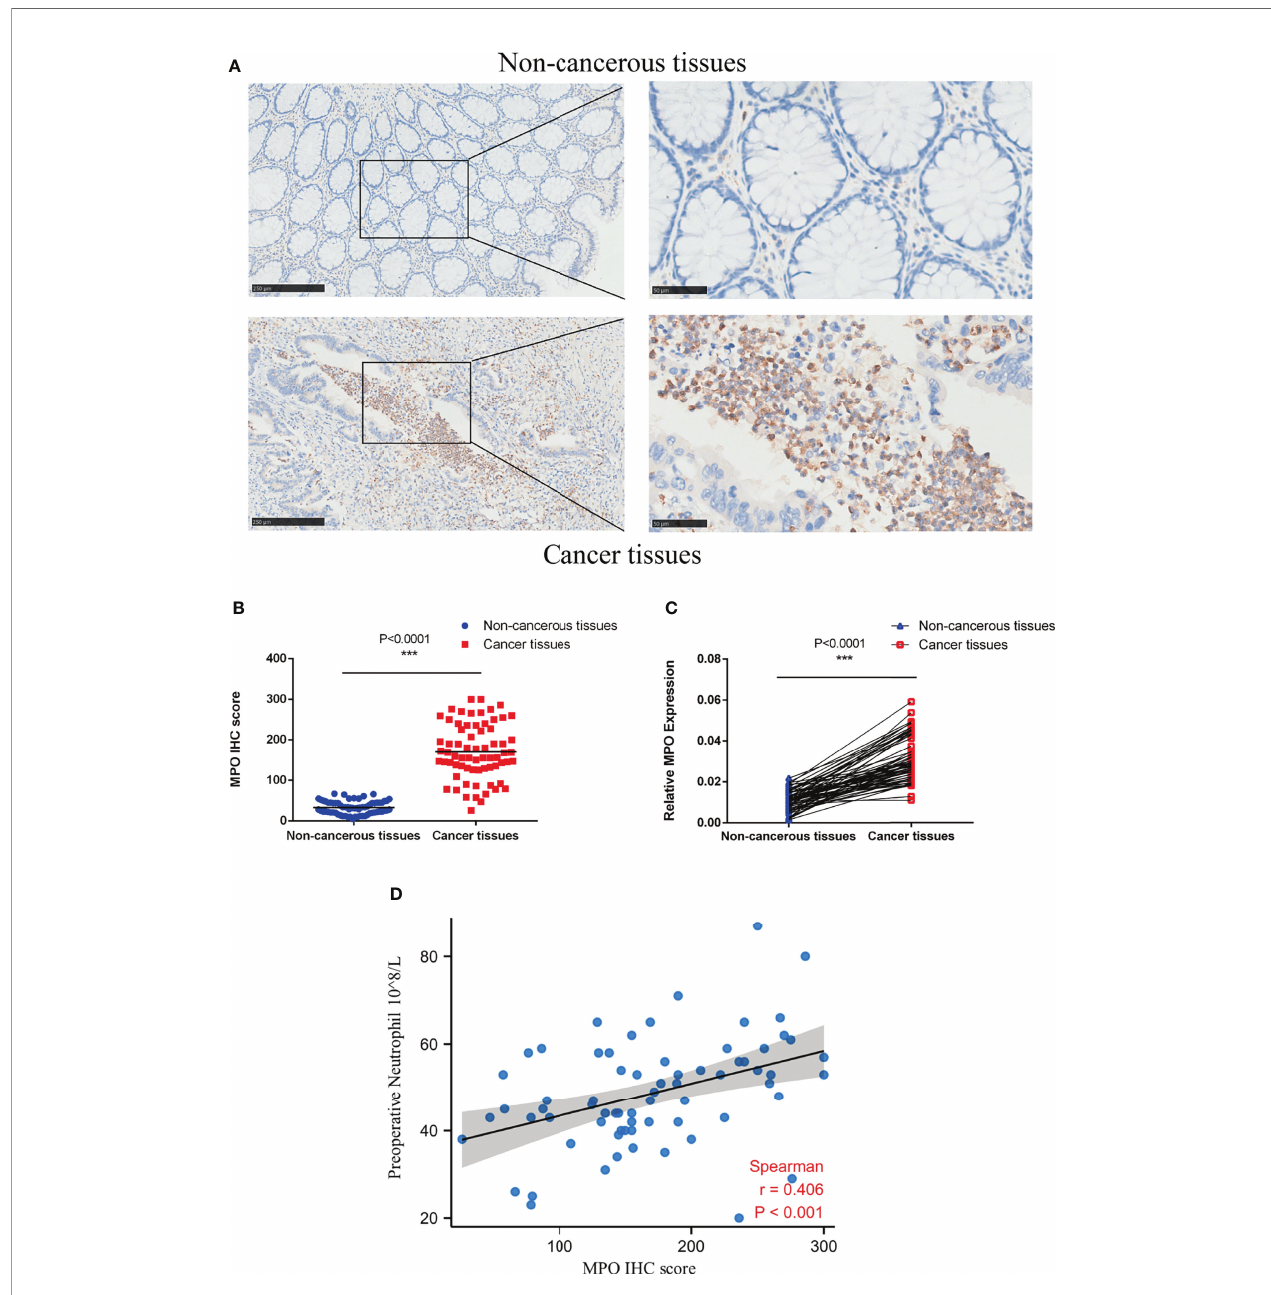
FIGURE 5 | MPO was upregulated in CRC and positively correlated with peripheral neutrophil counts. (A) IHC was used to detect MPO protein expression in CRC and non-cancerous tissues (69 pairs); left, scale bar = 250 µm; right, scale bar = 50 µm. (B) Quantitative analysis of MPO IHC scores in CRC and non-cancerous tissues (69 pairs). (C) qPCR was used to evaluate the relative expression of MPO mRNA in CRC and adjacent non-cancerous tissues (69 pairs). (D) The relationship between MPO levels in CRC and peripheral neutrophil counts was determined using Spearman ’ s correlation test (r = 0.406, P < 0.001, n = 69). Differences were considered signi fi cant at * P < 0.05, ** P < 0.01, or *** P <